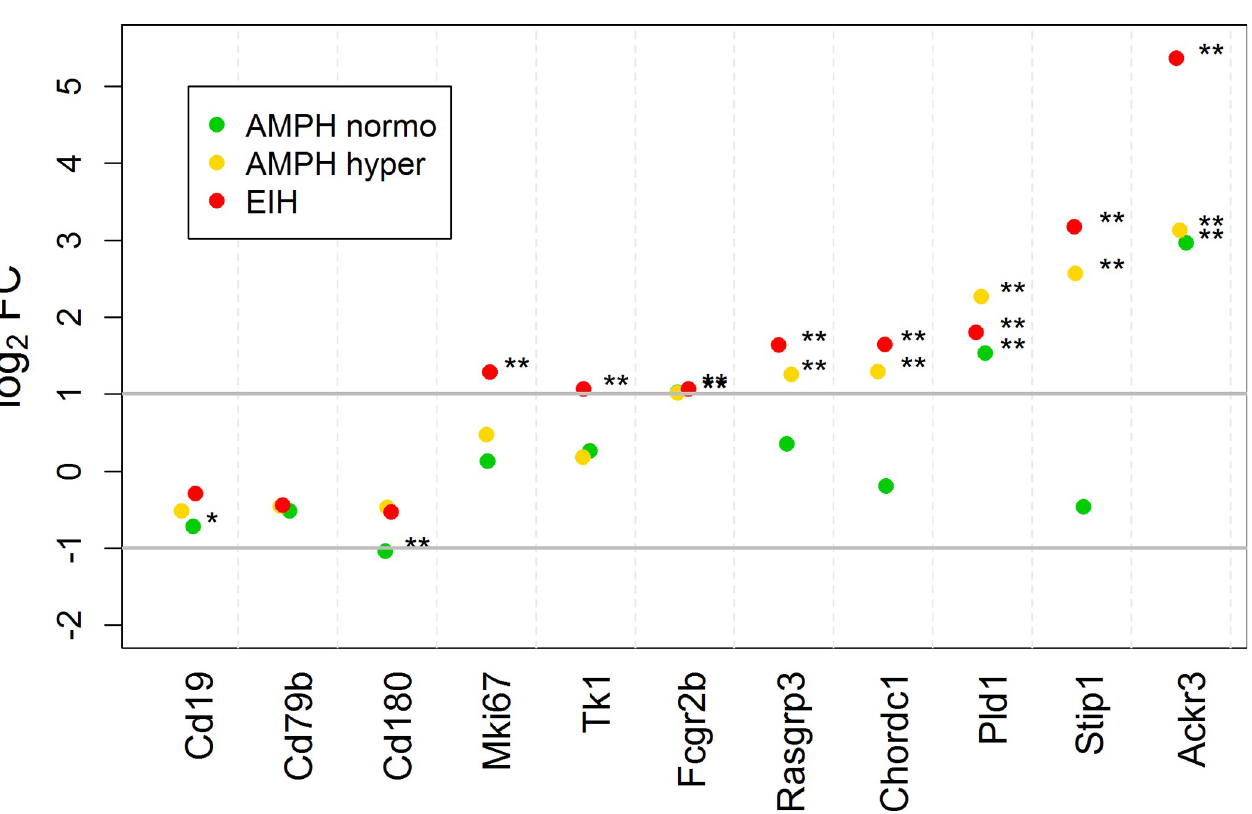
Fig 5. Scatterplot of fold-change expression for B-cell-specific mRNA transcripts in the whole blood. The log2 fold-change for the AMPH normo, AMPH hyper, and EIH groups relative to control. The horizontal gray bars indicate a 2-fold increase and decrease in expression compared to control. The subscripts � and �� indicate that the fold-change is significant and exceeds 1.5 and 2, respectively.